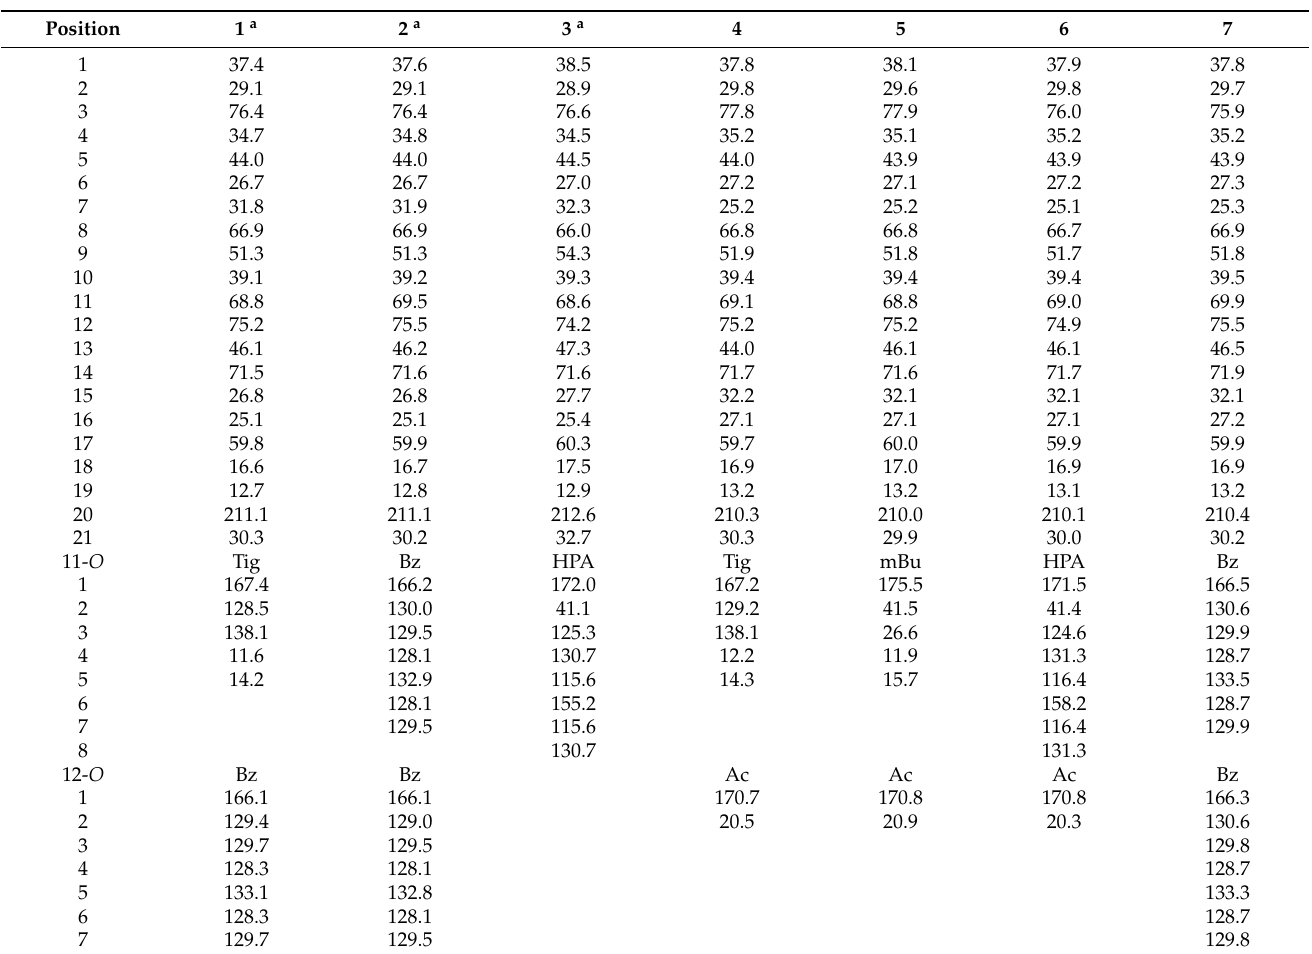
Table 1. 13 C NMR data of the aglycones of compounds 1 – 7 in pyridine- d 5 (125 MHz, δ in